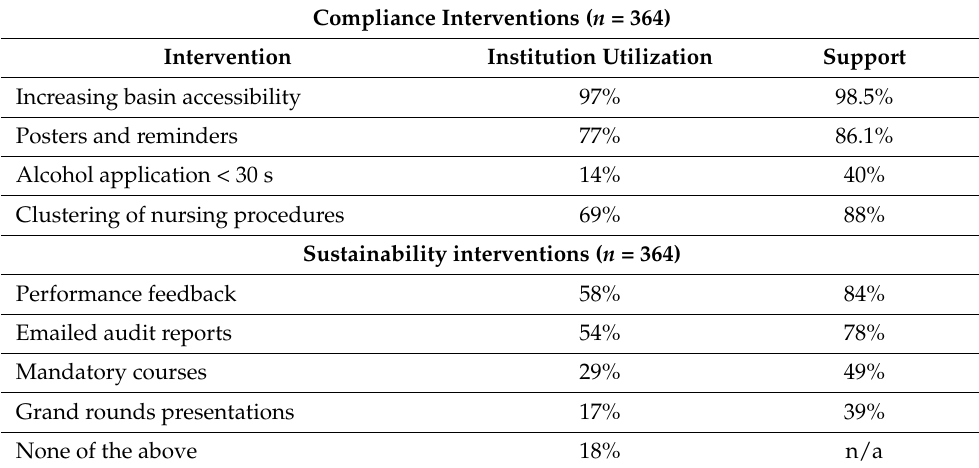
Table 4. Survey Results for Hand Hygiene Compliance.